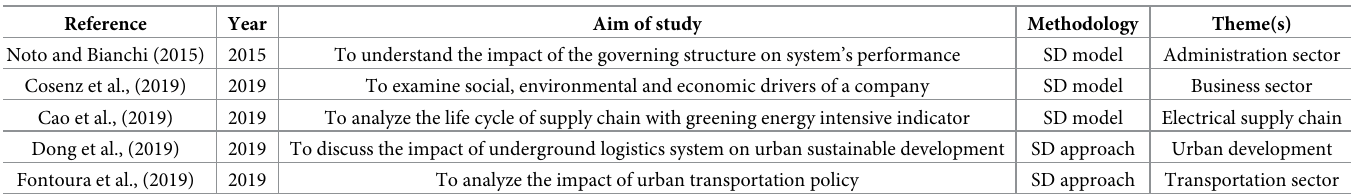
Table 1. Summary of applying themes of system